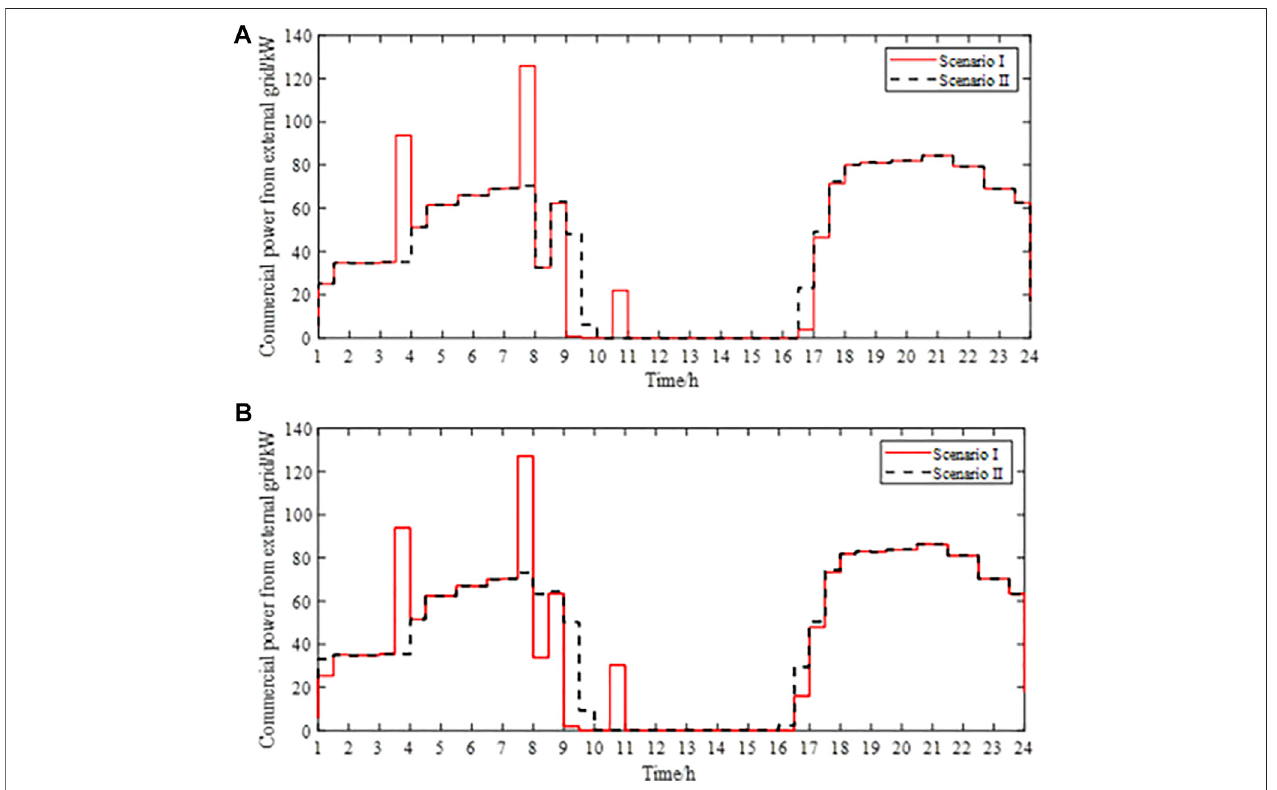
FIGURE 12 | Corresponding commercial power from the external grid when the optimal scheduling results are f opt- and f opt+ . (A) Commercial power from the external grid when the optimal scheduling result is f opt- . (B) Commercial power from the external grid when the optimal scheduling result is f opt+ .